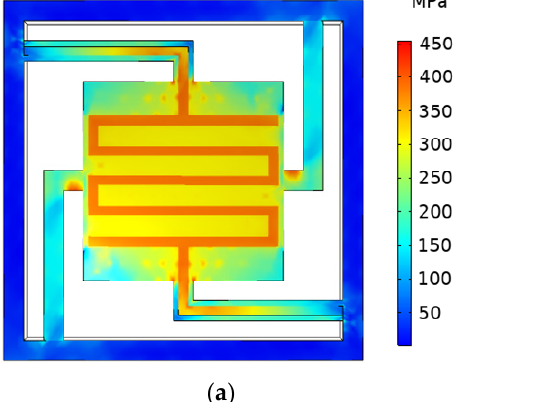
Figure 7. Cloud diagram of stress and deformation displacement simulation of Ⅱ ‐ ECLC model. ( a ) Cloud diagram of stress simulation; ( b ) cloud diagram of deformation and displacement simulation.